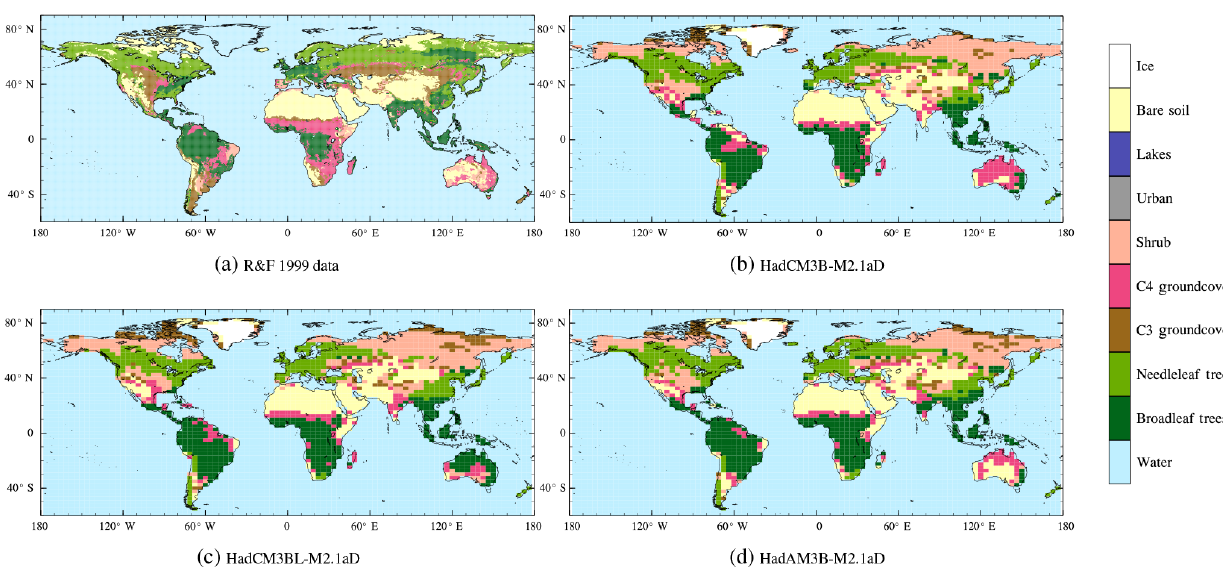
Figure 9. Maps of the dominant plant functional type for observations (a) and model simulations of the pre-industrial. The models shown are (b) HadCM3B-M2.1aD (c) HadCM3BL-M2.1aD and (d) HadAM3B-M2.1aD. The observed dataset for comparison is Ramankutty and Foley